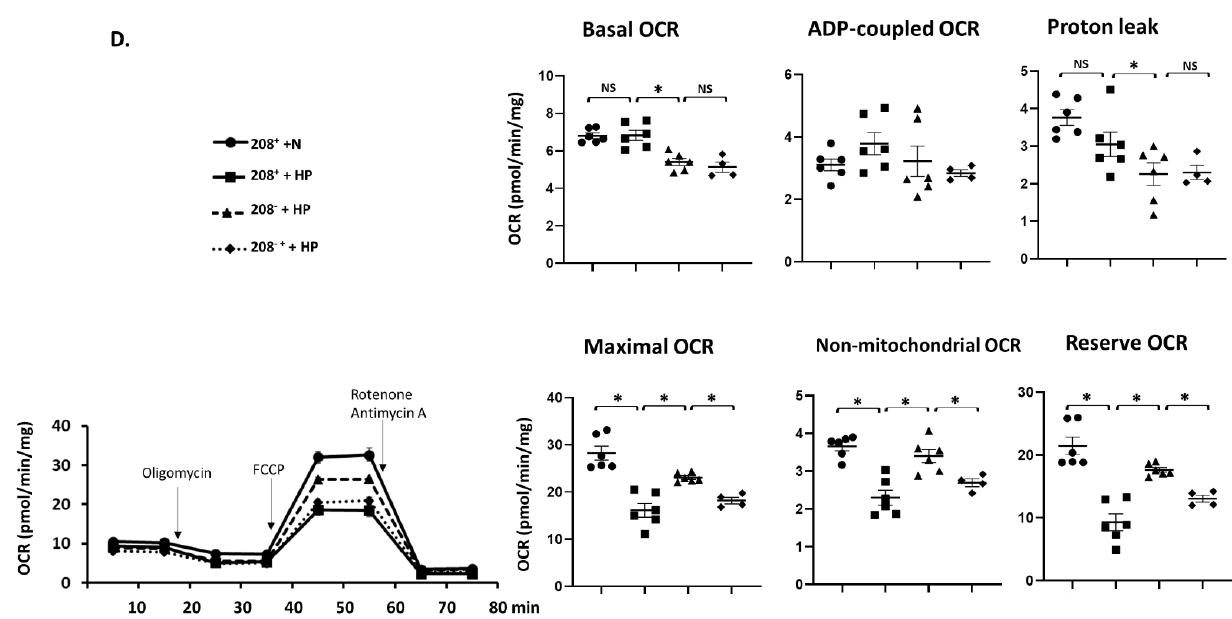
Figure 5. MiR 208a deficiency protects against the decrease in mitochondrial function induced by diabetic conditions. SV40 human cardiomyocytes were incubated in DMEM with 5 mM glucose, 25 mM glucose (high glucose, HG), or 20 µM bovine serum albumin (BSA)-bound palmitate (high palmitate, HP) for 24 h. Mitochondrial function was measured using an XFp Seahorse analyzer in bicarbonate- and phenol red-free DMEM supplemented with energetic substrates (10 mM glucose, 1 mM pyruvate, and 2 mM glutamine). ( A ) Respiratory properties induced by the miR 208a deficiency in cardiomyocytes exposed to normal conditions. ( B ) Respiratory properties induced by the miR 208a overexpression in cardiomyocytes exposed to normal conditions. ( C ) Respiratory properties of cardiomyocytes exposed to high-glucose (HG) conditions. ( D ) Respiratory properties of cardiomyocytes exposed to high-palmitate (HP) conditions. 208 + , wildtype cardiomyocytes that normally express miR 208a; 208 − , cardiomyocytes deficient in miR 208a; 208 ++ , wildtype cardiomyocytes transfected with miR 208a; 208 − + , cardiomyocytes deficient in miR 208a which were transfected with miR 208a. OCR, oxygen consumption rate (expressed as pmol/min/mg); ECAR, extracellular acidification rates (expressed as mpH/min/mg); FCCP (carbonyl cyanide- p -trifluoromethoxyphenylhydrazone). Respiratory parameters were measured or calculated as described in Section 2. The results are expressed as the mean ± SEM of four independent experiments. * p < 0.05.